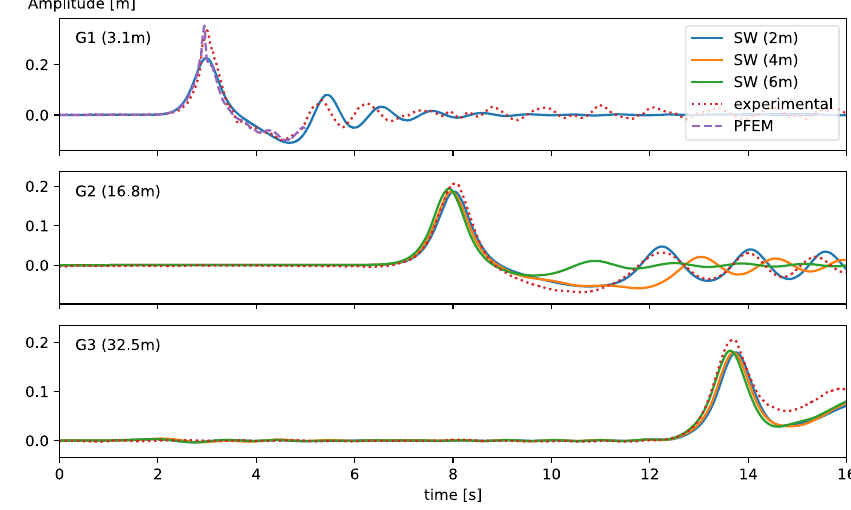
Fig. 11 Landslide wave problem. Time series of the wave amplitude at the different recording